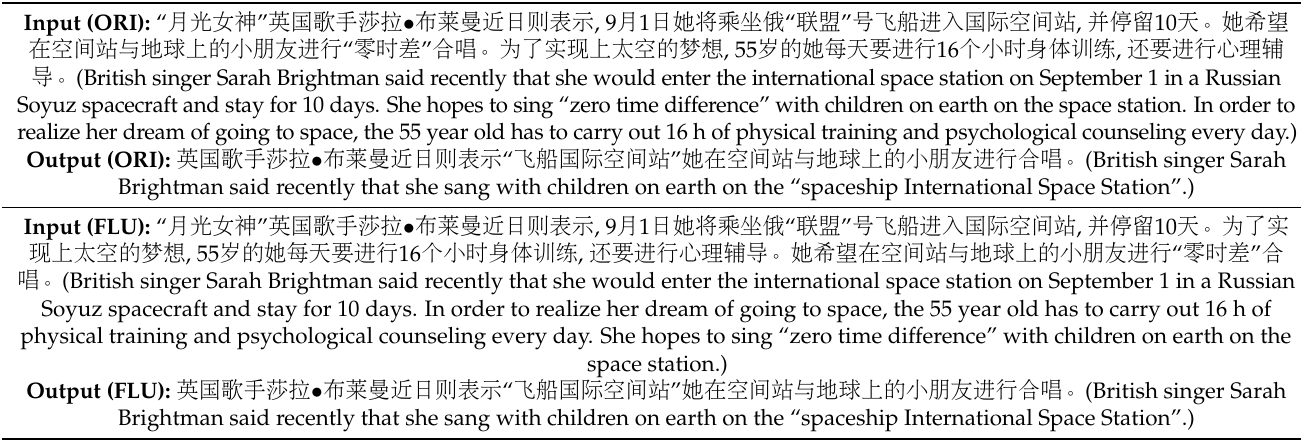
Table 4. Text summarization. MR7.2 explanation and simple example.